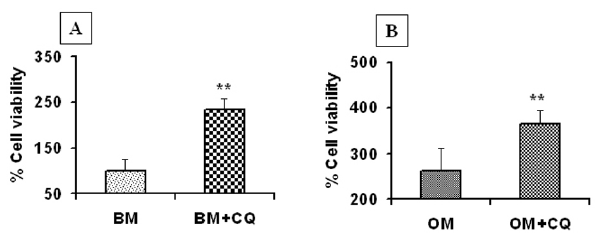
Figure 1 - Cissus Quadrangularis (CQ) treatment increases the proliferation rate of undifferentiated MSCs: Proliferation assay (MTT assay) of MSCs grown in basal media (A) and osteogenic media (B). Treatment with 300 µg/ mL CQ extract increases the proliferation rate by two-fold in basal media (CM+CQ) and by three-fold in osteogenic media (OM+CQ). ** = P<0.01, as compared to control cells. Data is represented as a percentage and is an average of three independent experiments